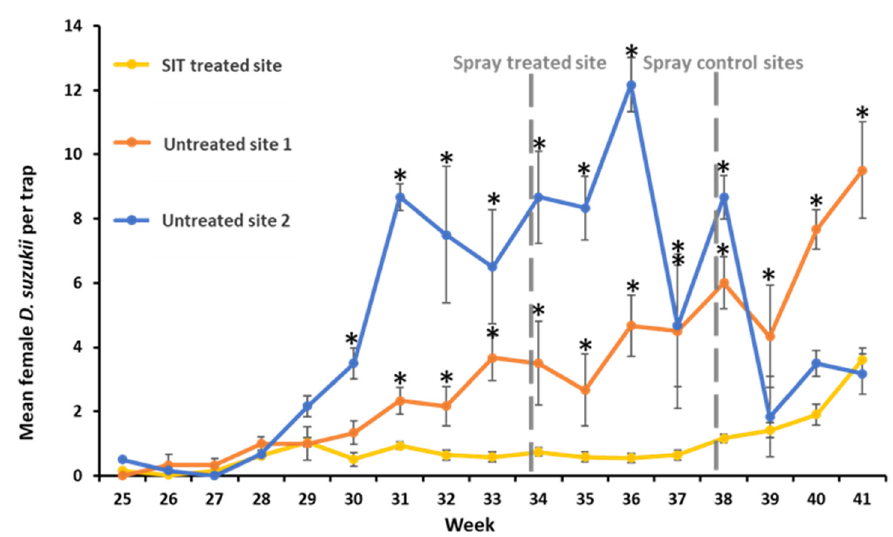
Figure 5. Mean numbers of female D. suzukii (±SE) captured per trap and per week at the SIT-treated and untreated control sites throughout the trial. Statistically significant differences ( p ≤ 0.05; GLM mixed model) between the SIT-treated site (yellow line, n = 31) and each of the untreated control sites 1 (blue line, n = 6) and 2 (orange line, n = 6) are represented by an asterisk above the error bars for each week. Foliar insecticide application (cyantraniliprole (100 g L − 1 ) at a rate of 750 mL ha − 1 ) at the SIT-treated and untreated control sites are highlighted by vertical grey dashed lines.